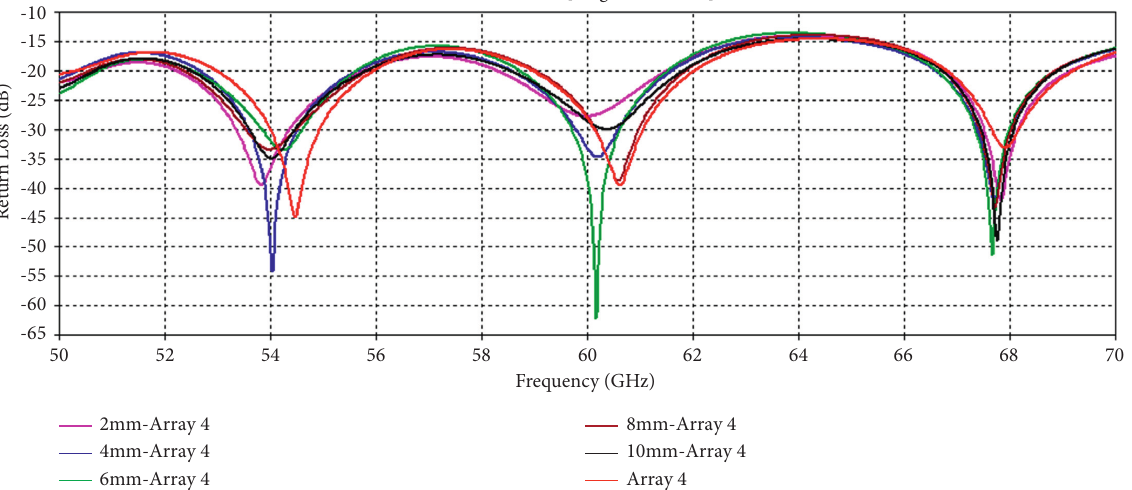
Figure 29: Simulated Array 4 on-body return loss at different distances compared to free